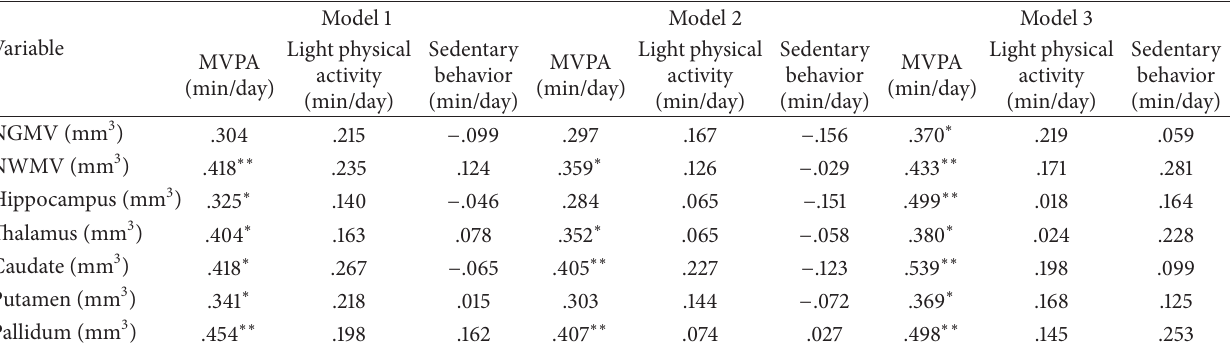
Table 2: Correlations between levels of physical activity and scaled composite volumes of normalized brain volume measures in 39 persons with